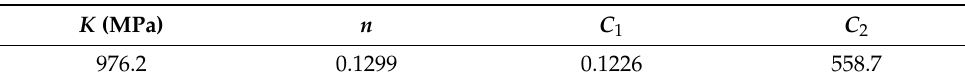
Table 4. Parameters used in the MMC fracture locus (3D).